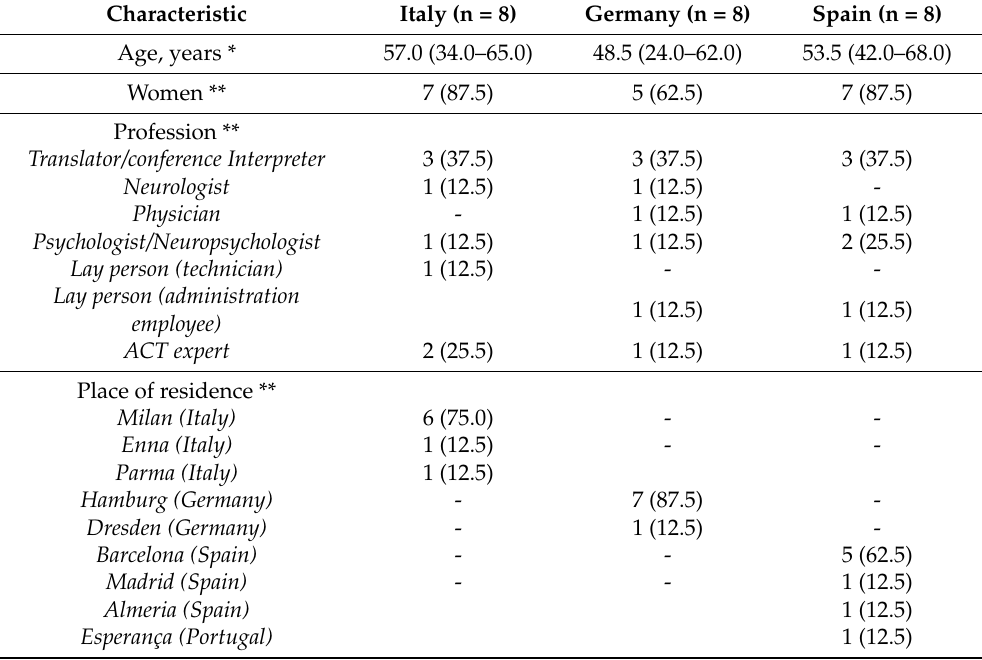
Table 1. Characteristics of the translation